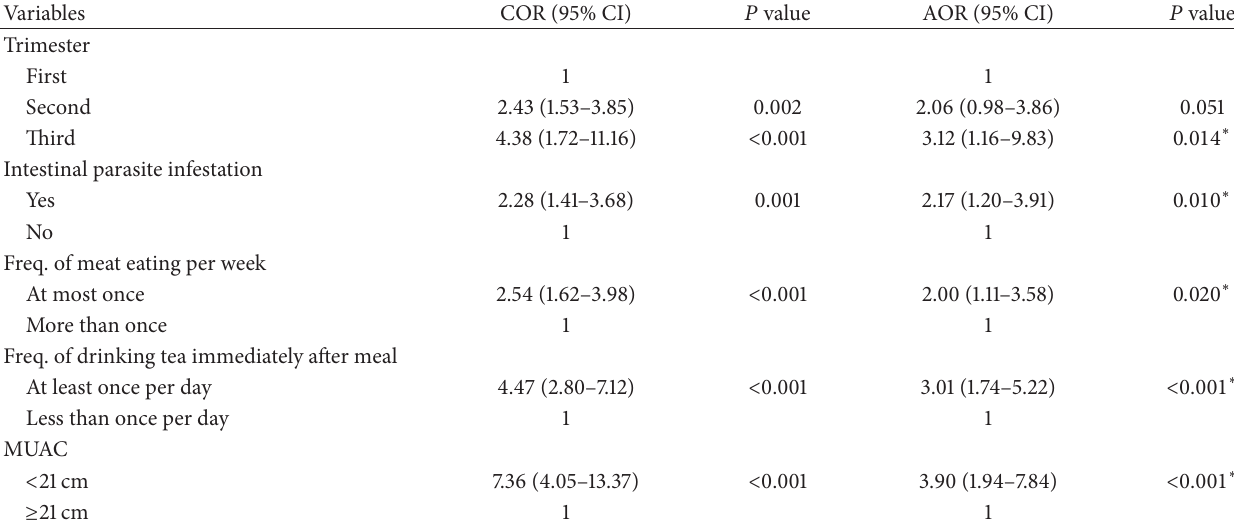
Table 4: Independent predictors of anemia among pregnant women attending ANC clinic at Pugnido ARRA Health Center in Gambela, Western Ethiopia, April 15–June 30/2015 ( 𝑛 = 360